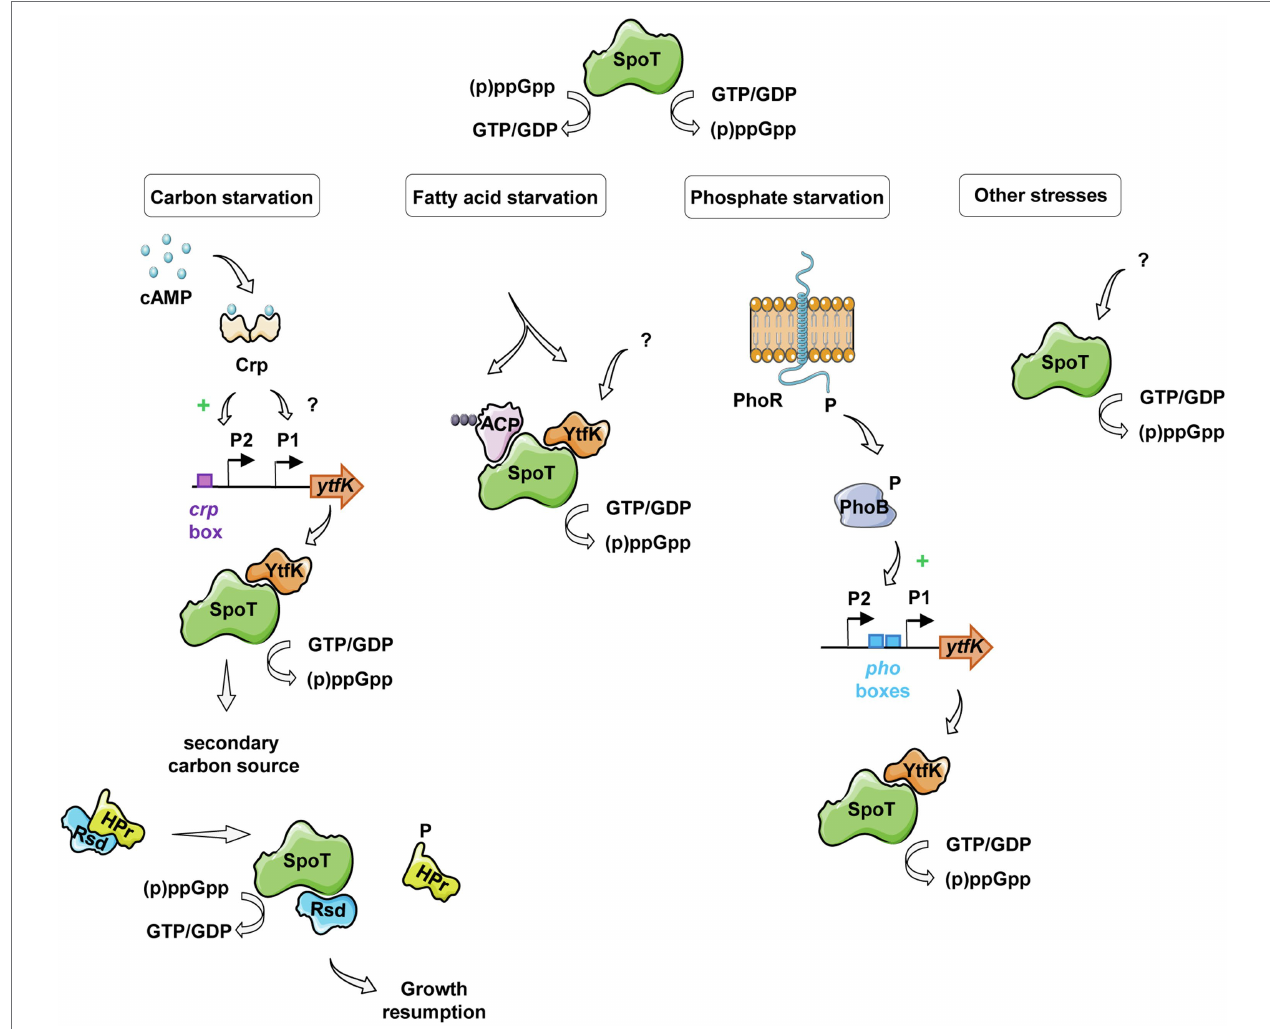
FIGURE 6 | Schematic view of SpoT integration signals and its regulation in response to various starvations in E. coli . Under glucose starvation, an increase of cAMP concentration activates the CRP protein, which induces ytfK transcription by direct binding to the ytfK P2 promoter and by an unknown and probably indirect mechanism for the ytfK P1 promoter. YtfK thus interacts with the catalytic domains of SpoT (Germain et al., 2019), promoting the accumulation of (p)ppGpp. The availability of a secondary carbon source releases the anti- σ 70 Rsd protein from HPr, which can interact with the C-terminal regulatory domain of SpoT, rebalancing its (p)ppGpp synthesis activity toward hydrolysis allowing growth resumption (Lee et al., 2018). In response to fatty acid starvation, YtfK also promotes SpoT- dependent accumulation of (p)ppGpp (Germain et al., 2019) and on the other hand, the nature of the fatty acid intermediates bound to ACP differs and induces conformational changes in the protein leading to SpoT-dependent (p)ppGpp accumulation (Battesti and Bouveret, 2006). During phosphate starvation, the PhoR- PhoB two-component system mediates signal transduction that results to induce ytfK transcription which could orchestrate SpoT-dependent (p)ppGpp accumulation (Spira et al., 1995; Spira and Yagil, 1998; Baek and Lee, 2006; Yoshida et al., 2011; Iwadate and Kato,